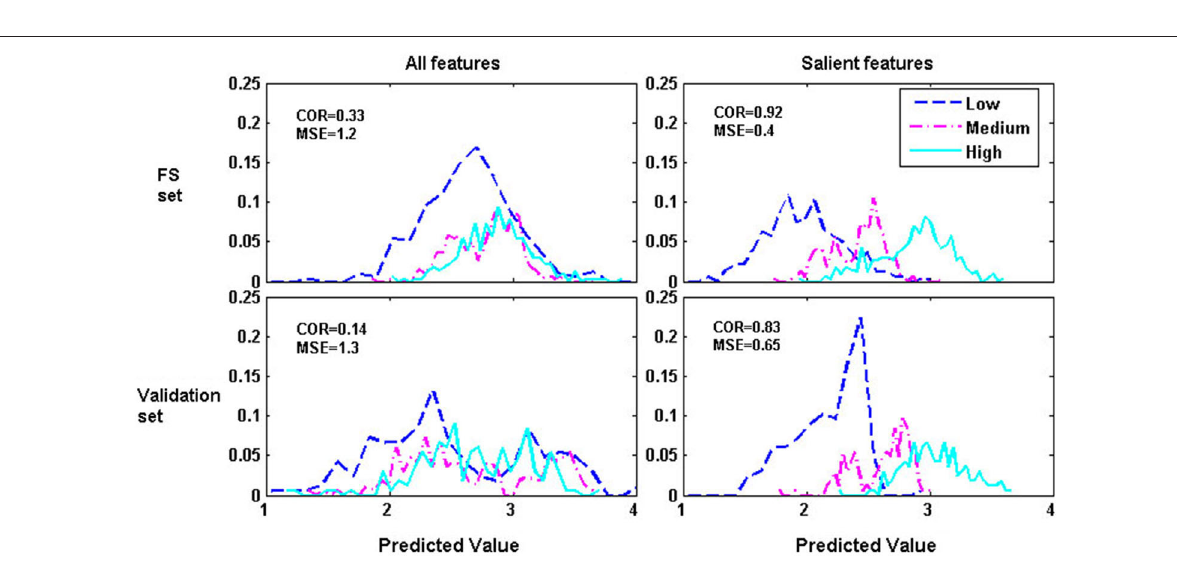
validation respectively). This kind of effect may result from the mismatched workload between training and testing